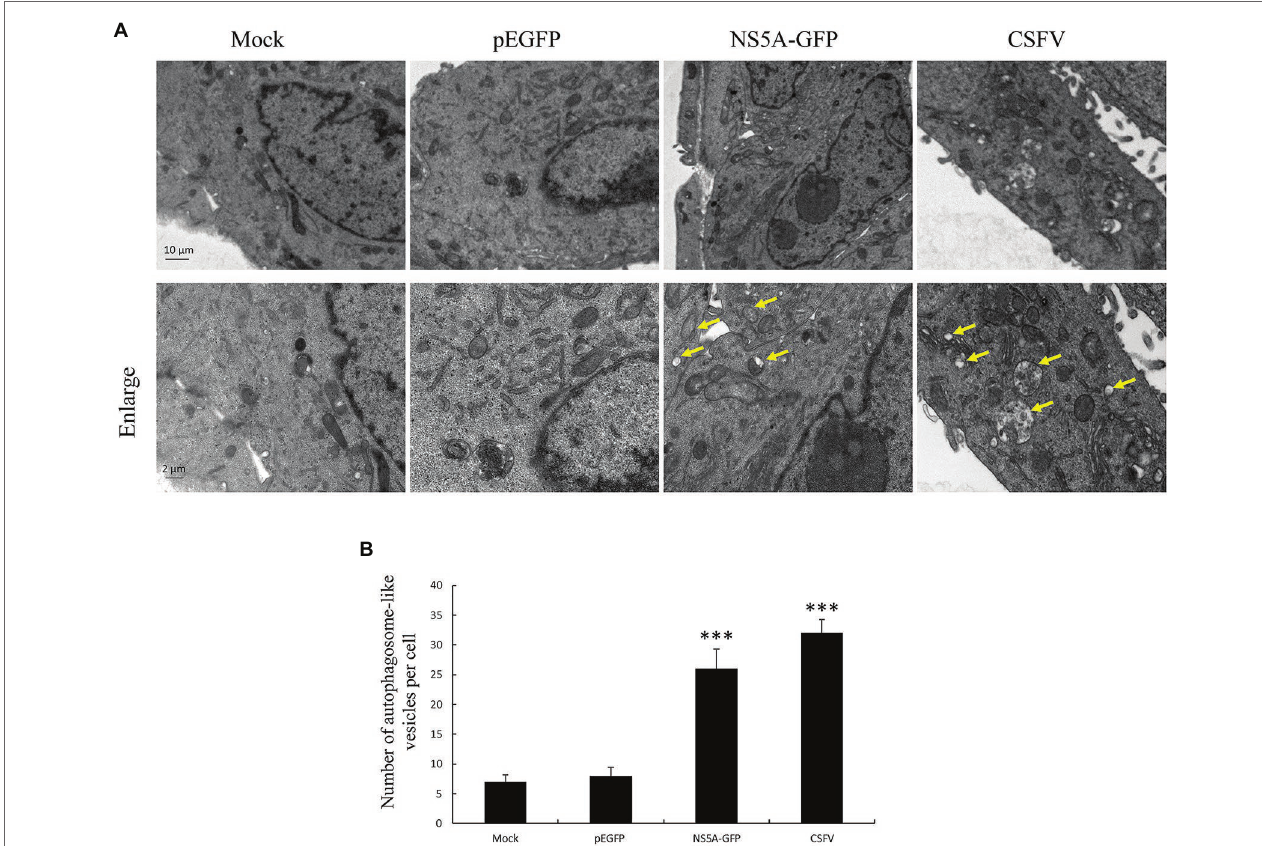
FIGURE 1 | Nonstructural protein 5A (NS5A) protein raises the number of autophagosome-like vesicles. (A) PK-15 cells were transfected with a pEGFP or NS5A- GFP vector and mock-infected or infected with classic swine fever virus (CSFV) at an MOI of 1 for 36 h, followed by electron microscopy examination. Yellow arrows indicate the structures with the characteristics of autophagosomes. (B) Quantification of autophagosome-like vesicles per cell image. The data represent the mean ± SD of three independent experiments. Statistical comparisons were evaluated using ANOVA followed by Tukey’s HSD post hoc analysis. *** p < 0.001, compared with the mock